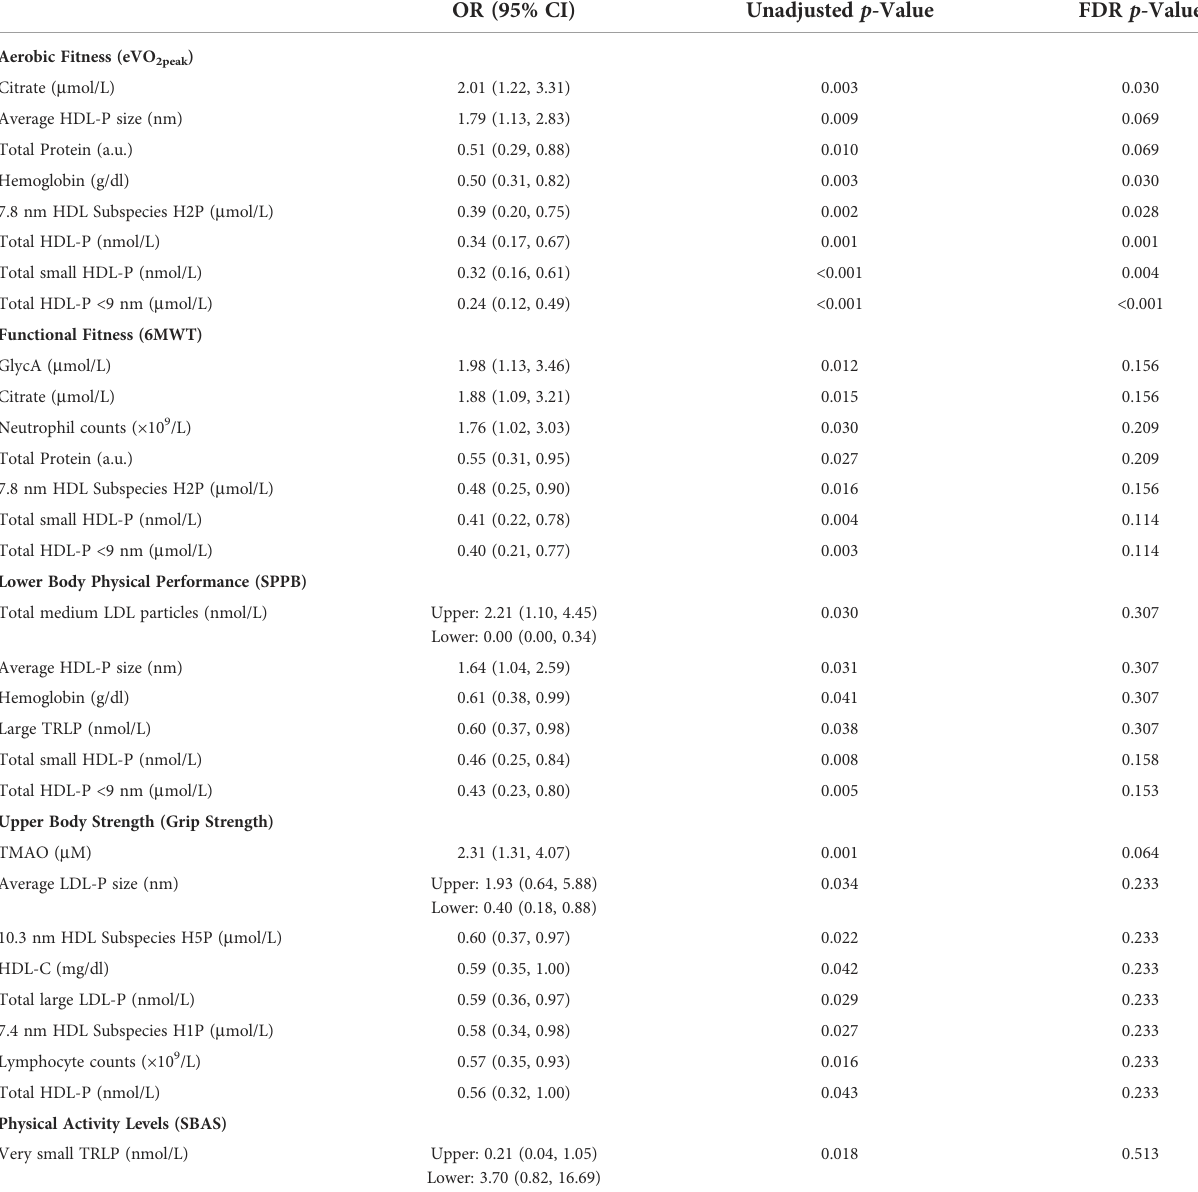
TABLE 4 Univariable associations between circulating blood measures and the odds of having dysfunctional physical characteristics *